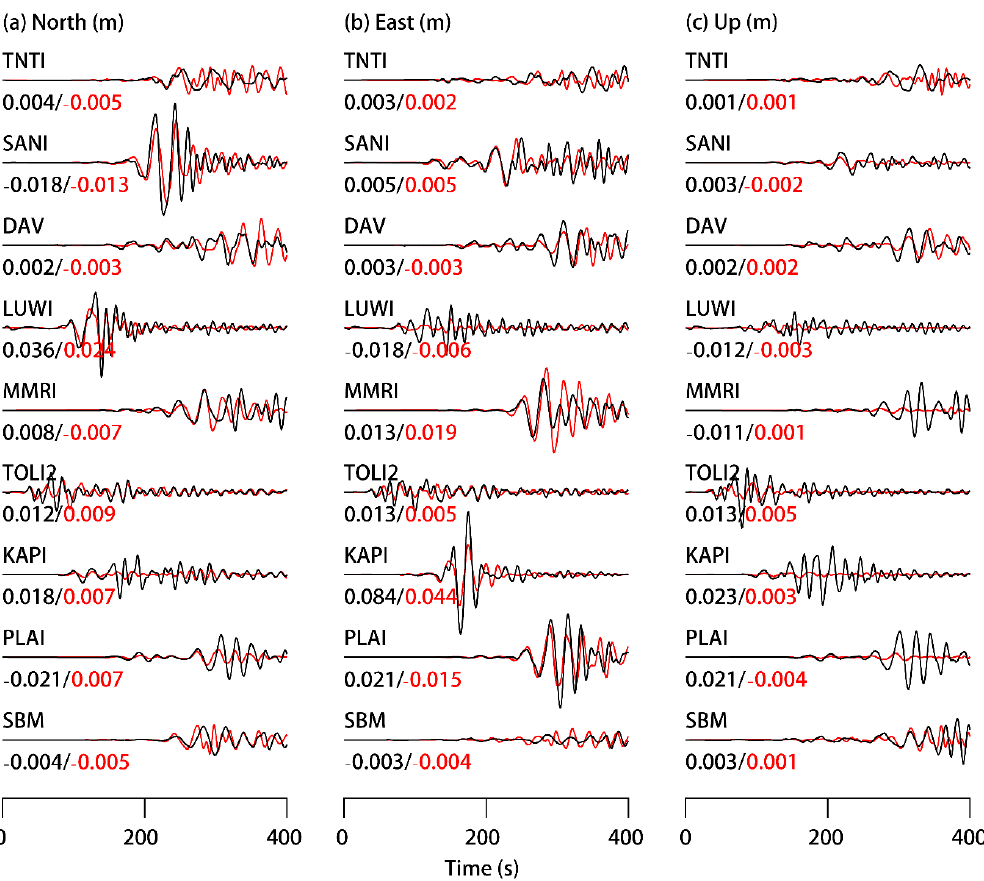
Figure 5. The observed ( black ) and synthetic ( red ) broadband displacement waveforms for the north ( a ), east ( b ), and up ( c ) components respectively. Station names (e.g., TNTI) and corresponding amplitudes for the observed (in black) and synthetic (in red) displacements are also labeled.